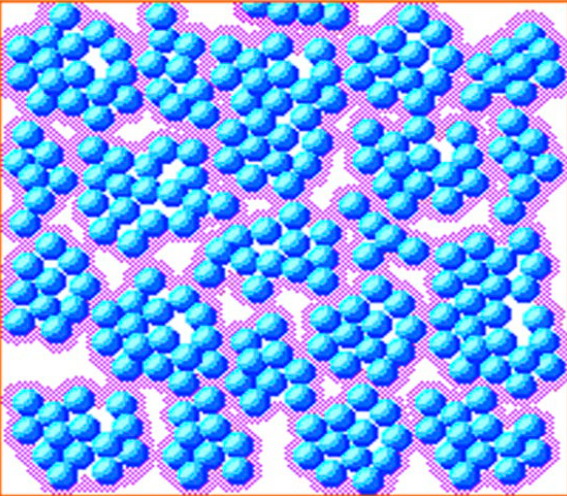
Figure 50. Maximum thickening effect and thixotropy are produced by small aggregates linking together into an extensive three-dimen- sional gel network throughout the liquid medium. Natural silica gel occurring as the precursor to vein quartz is thought to be partly precipitated (white colour), thixotropic, and dense enough to sup- port mineral and wall rock fragments. In most cases it is probably of this type. [From Iler, 1979, p. 591]